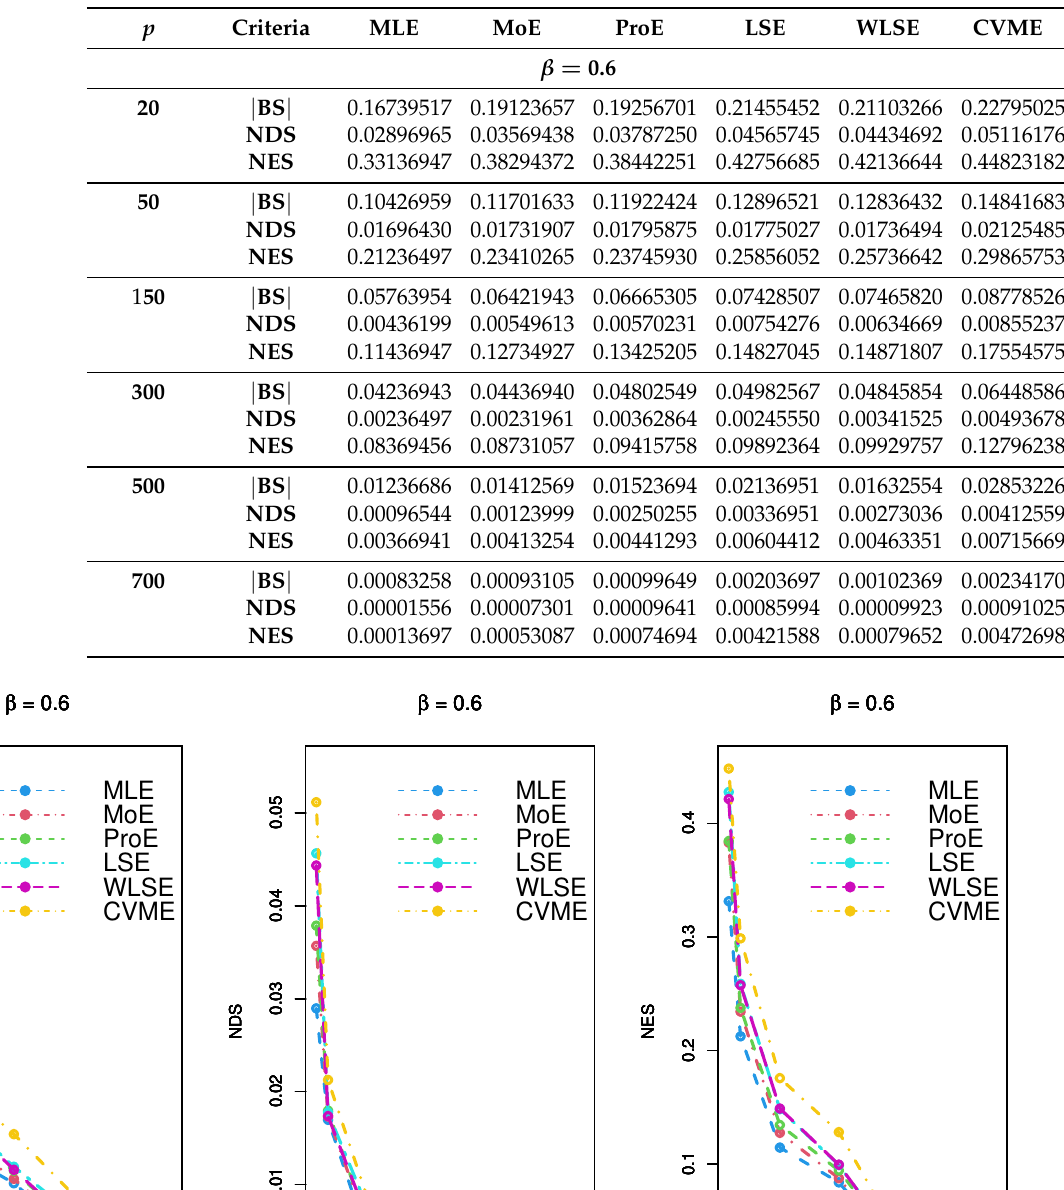
Table 3. The performance of different estimators.